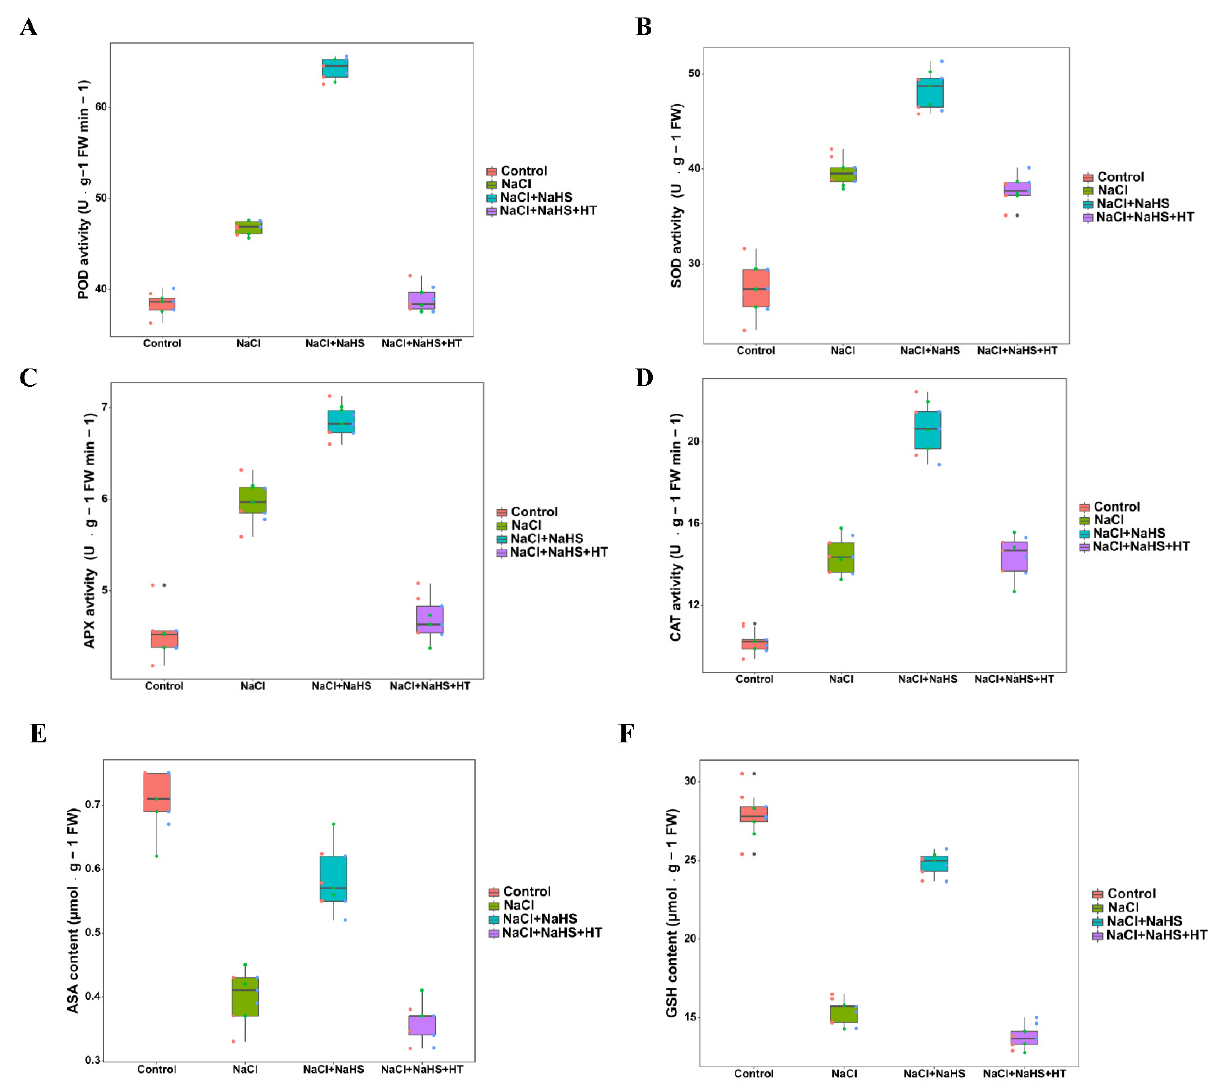
Figure 7. Effect of NaHS application on antioxidant enzyme activity [POD ( A ), SOD ( B ), APX ( C ), CAT ( D )] and antioxidants [ASA ( E ) and GSH ( F )] in explants. The primary roots were removed from hypocotyl of 5-day-old seedlings. Explants were incubated for 5 days with distilled water (the control), NaCl, NaCl + NaHS, NaCl + NaHS + HT. Values are means of three independent replicates.